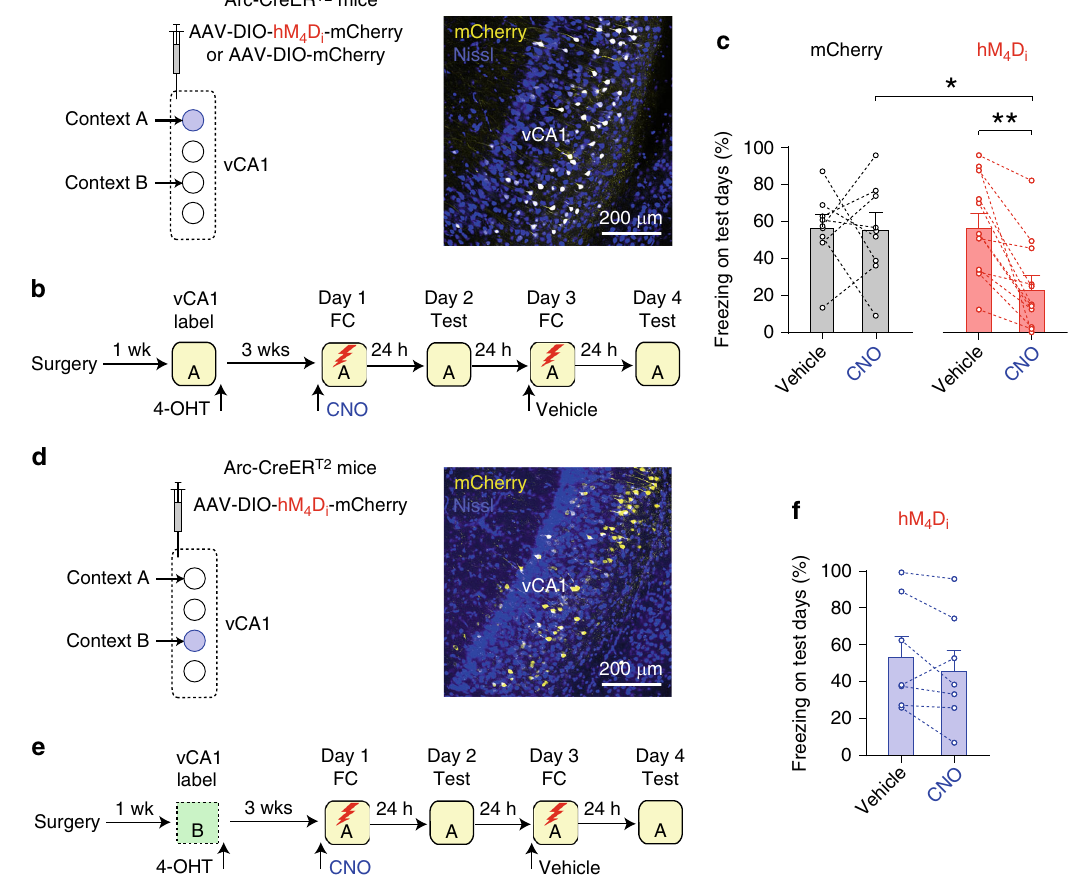
Fig. 9 Context-speci fi c vCA1 neuronal activity is involved in the acquisition of contextual fear memory. a Left: experimental setup for b and c . vCA1 neurons active in Context A expressed hM 4 D i -mCherry (hM 4 D i group) or mCherry (mCherry group) in Arc-CreER T2 mice. Right: images showing mCherry-labeled vCA1 neurons (yellow). b Behavioral training and testing protocols for c . After labeling Context A vCA1 neurons, mice received a CNO